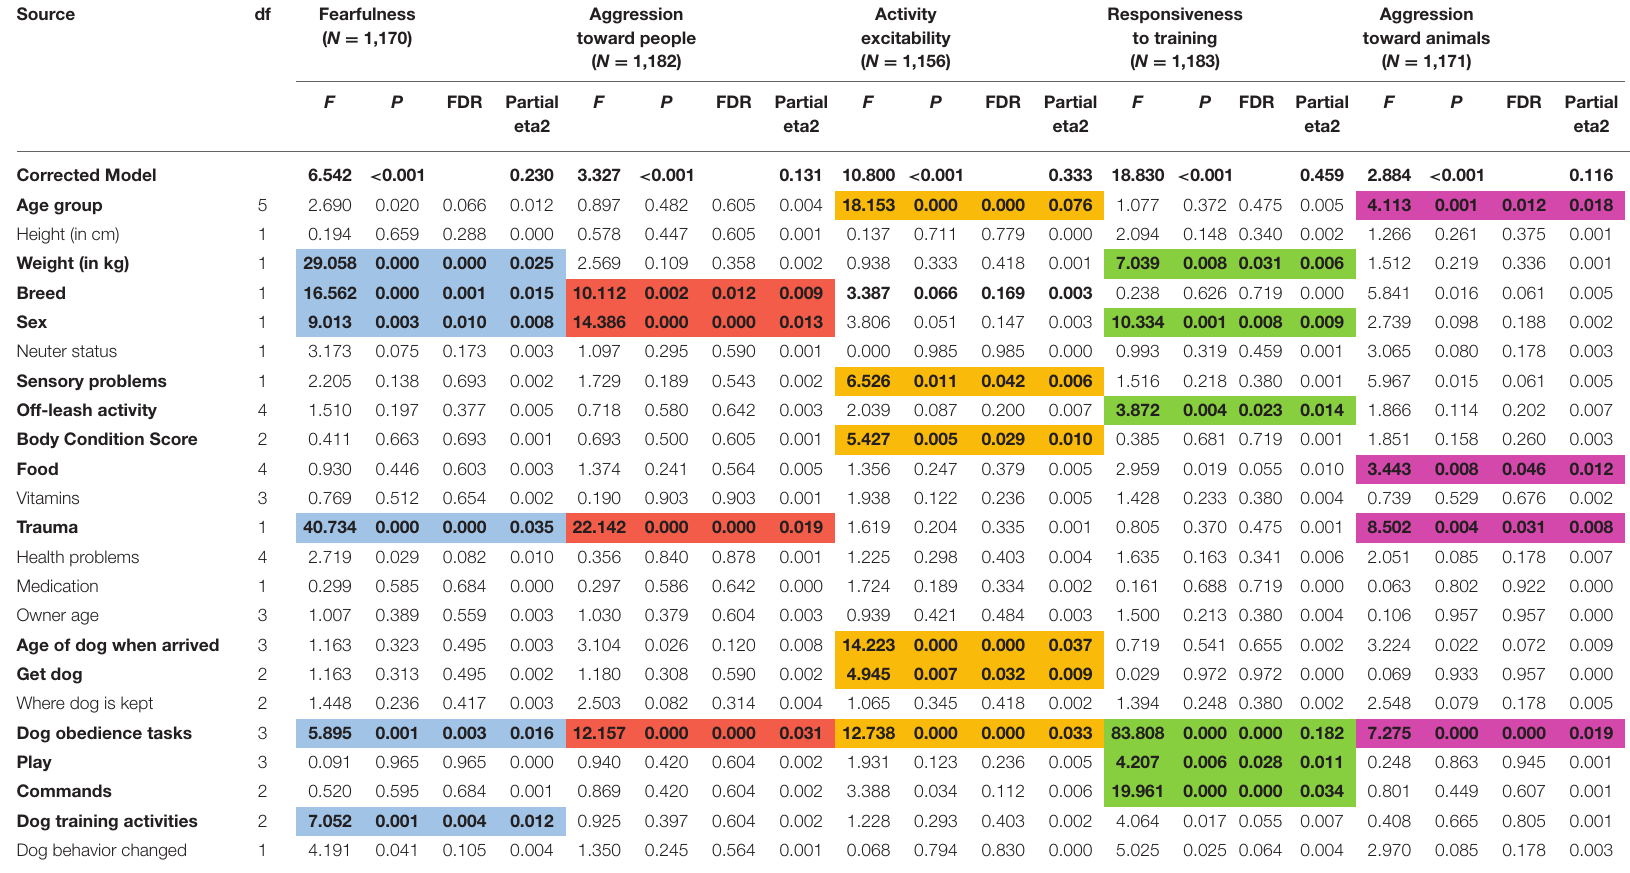
Owner experience, Other dogs in the household, People in household, Child, and Time spent alone were removed from the model, as all p values were non-significant, and none of these variables differed among the age groups. All other non-significant effects remained in the model in order to control for age effects on the explanatory variables. P values were corrected for multiple comparisons using the false discovery rate procedure (FDR). Significant predictors are highlighted in bold and colored (p ≤